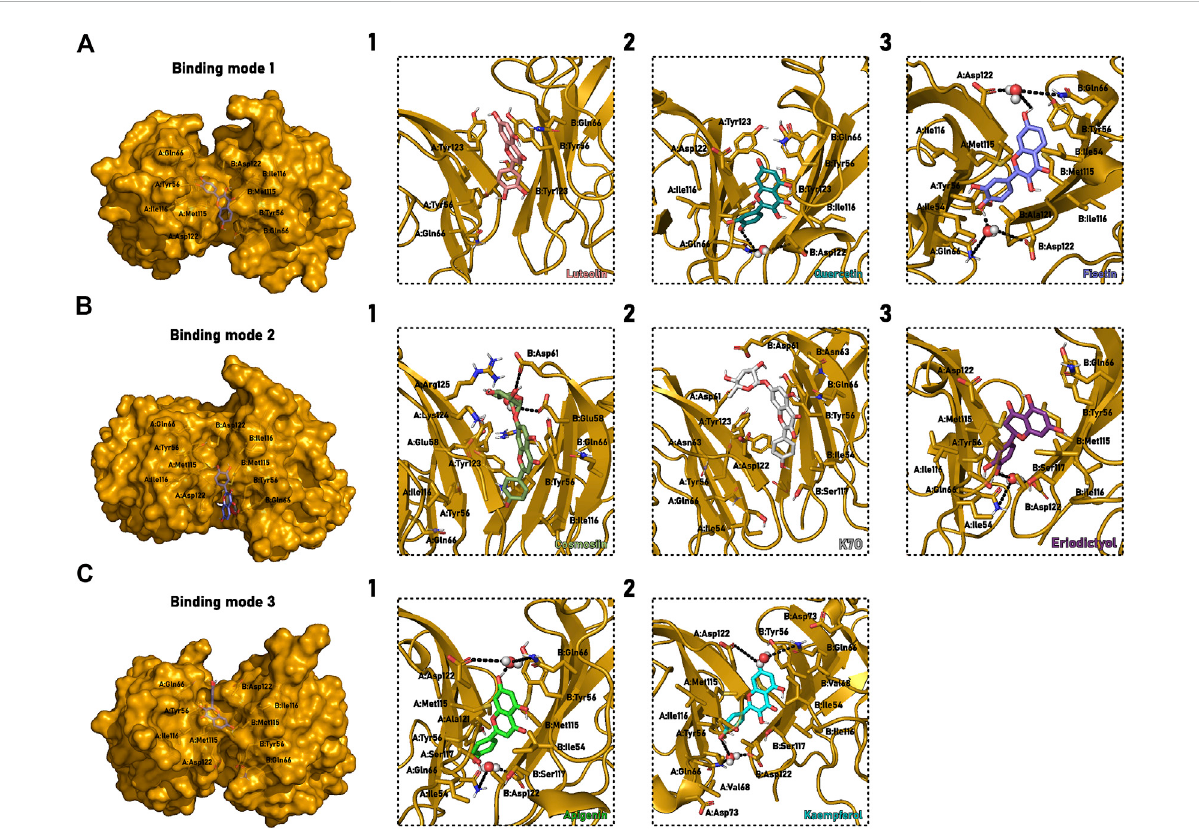
FIGURE 8 Flavonoids selected binding mode in the cavity between the monomers that form the PD-L1 dimer. (A) Binding mode 1, characterized by hydroxyphenyl and chromen-4-one buried between the dimer β -sheets. (B) Binding mode 2, described by the buried hydroxyphenyl. (C) Binding mode 3, marked by the buried chromen-4-one group. (1 – 3) Detailed description of C1 PD − L1d binding cavity (yellow cartoon) with the interacting residues and molecules highlighted (sticks). Different colors describe the various fl avonoid: (A1) Luteolin, salmon; (A2) Quercetin, teal; (A3) Fisetin, blue; (B1) Cosmosiin, dark green; (B2) Kaempferol-7-O-rhamnoside, or K7O, grey; (B3) Eriodictyol, purple; (C1) Apigenin, green; (C2) Kaempferol, cyan. Water molecules forming Hydrogen-water-bridges are represented as spheres, and the interactions are black dash lines. The representation used the same perspective for all molecules, although PD-L1 d is a symmetric homodimer and the interactions can occur in two different